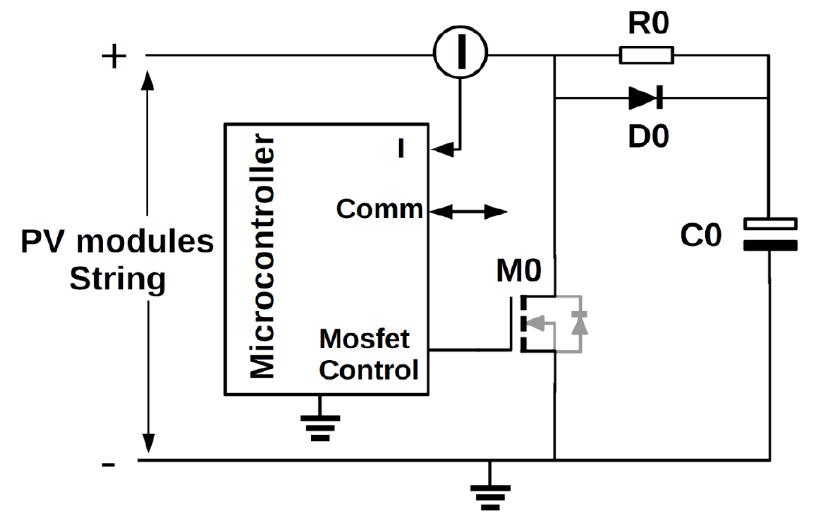
Figure 7. General schema of setup for mixed strategy.